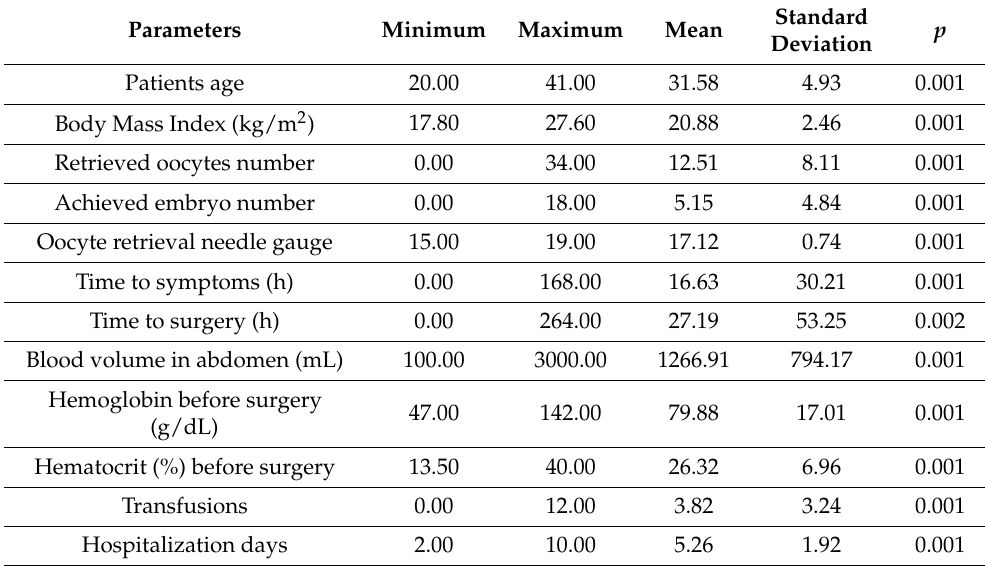
Table 2. Descriptive data of pooled sample (patients from our Clinic and previous